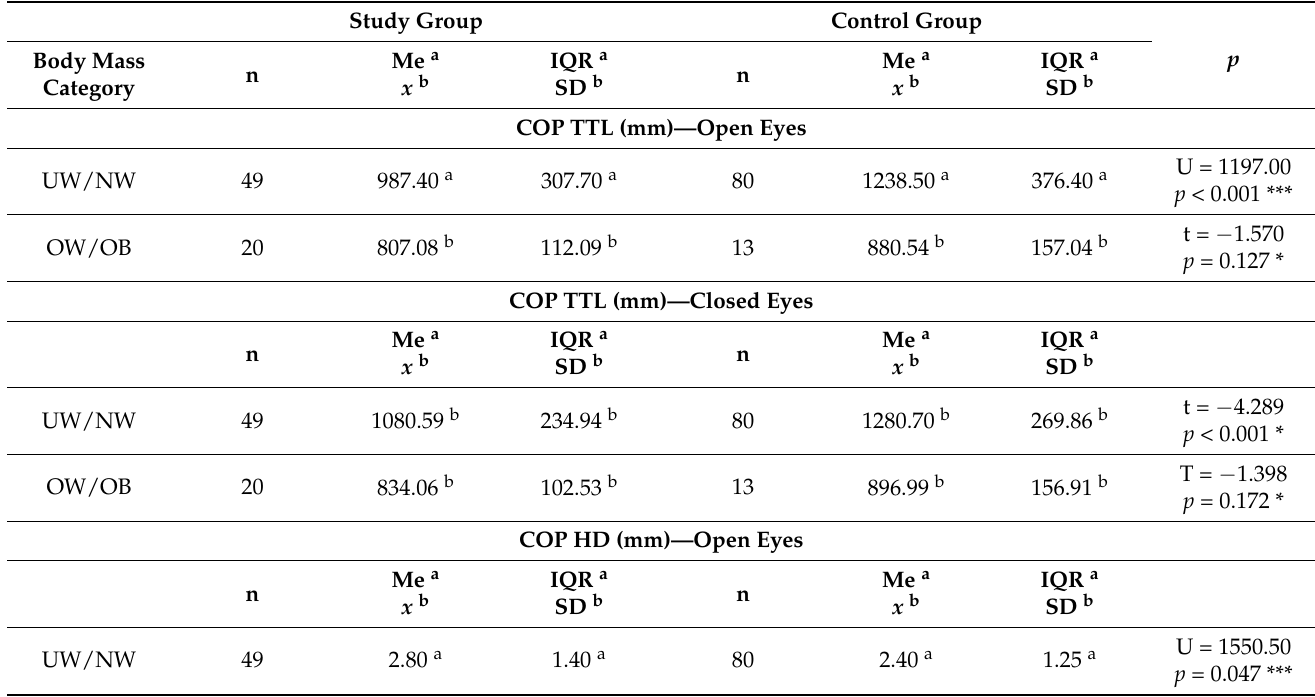
Table 5. Differences in the values of the center-of-pressure between the study and control groups considering the body weight